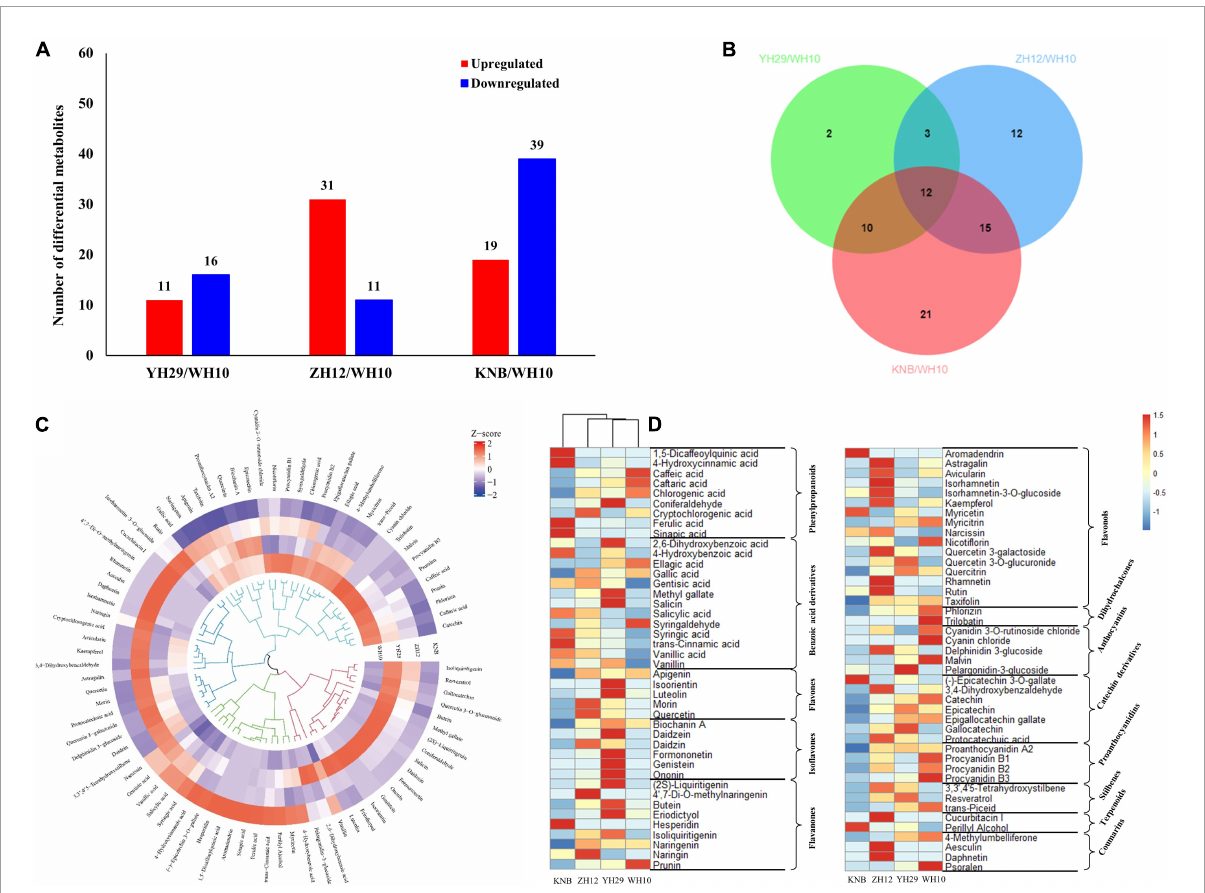
FIGURE3 Statistics of distinguished metabolites in four peanut testa samples with different colors. (A) Differential accumulated metabolites (DAMs) between WH10 of the most common pink testa and other three. The blue color represents down-regulated metabolites, and the red color represents up-regulated metabolites. The significant difference conforms to p < 0.05 and | log2(FC) | > 1. (B) Venn diagram exhibiting the number of the key flavonoids related to the pink testa color. (C) The circular plot of hierarchical cluster analysis illustrating the classification of flavonoids. (D) The heatmap of differential metabolite divided into 13 subgroups. Row data is normalized into